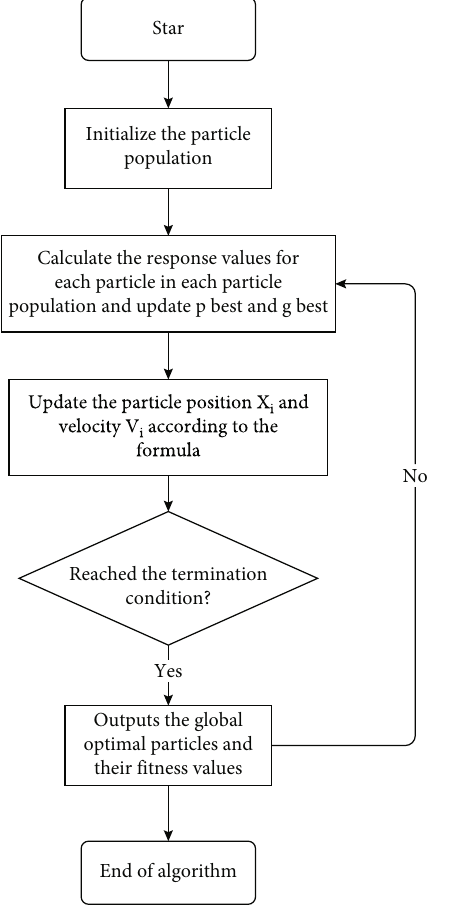
Figure 3: Flowchart of the improved particle swarm